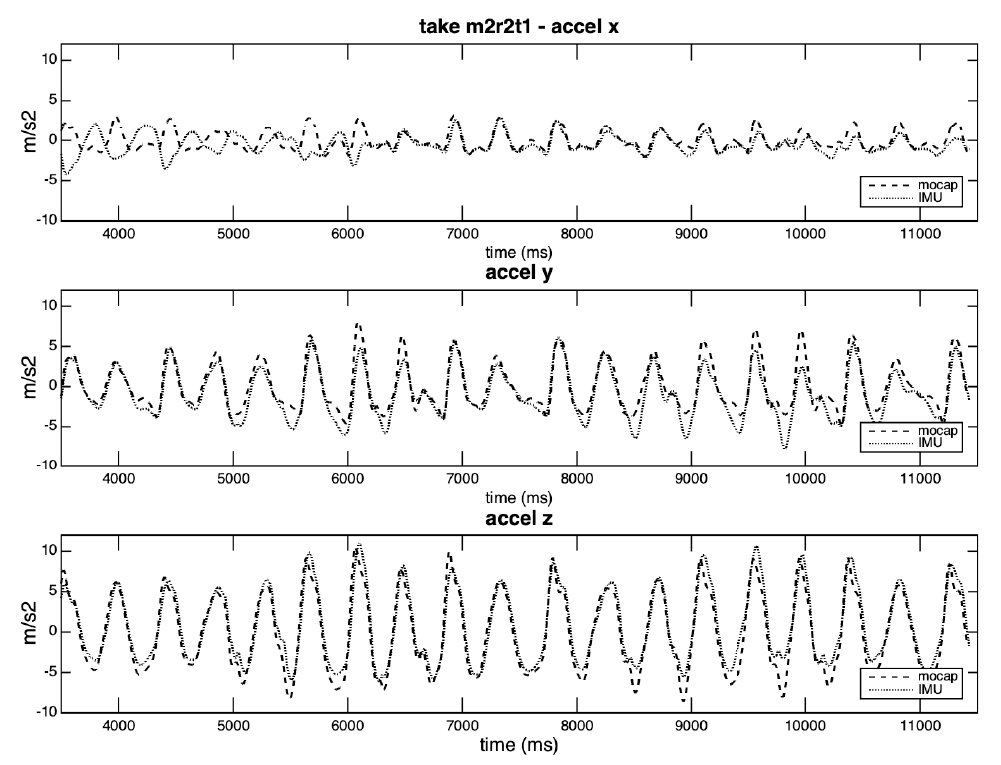
Figure 14. Acceleration curves per axis in take